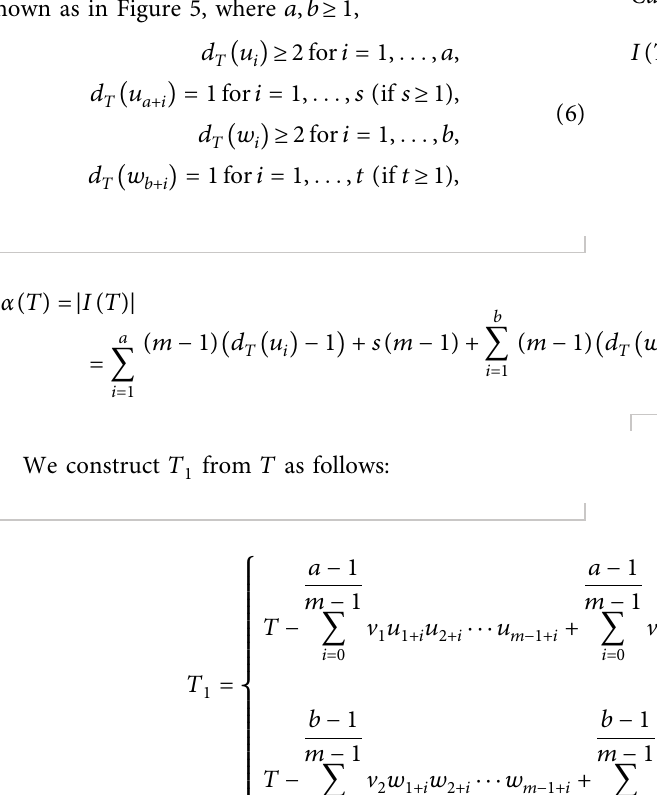
\( T 1 m,n,n − k m,n,n − k ∪